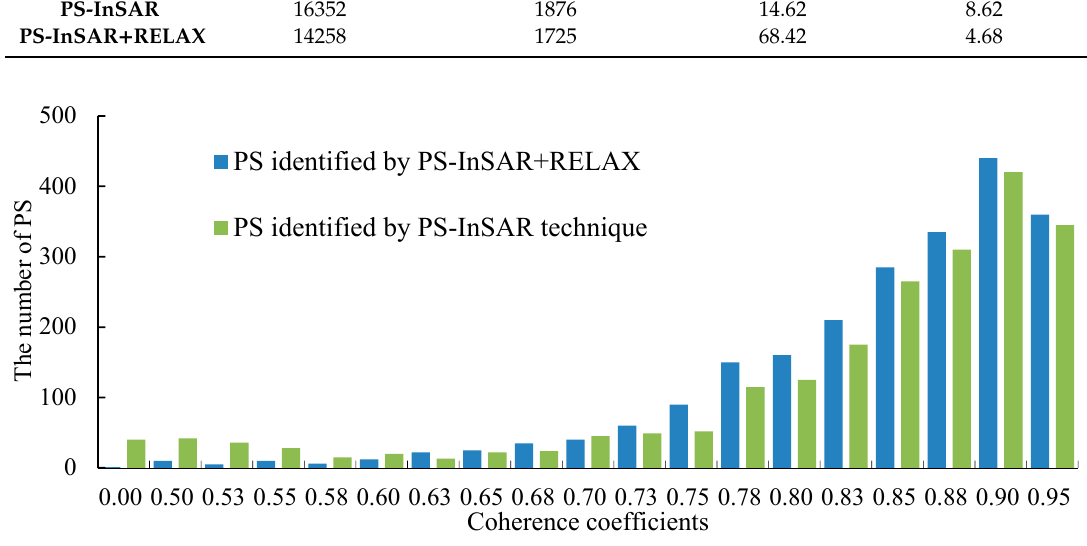
ffi cients for PS-InSAR and PS-InSAR + Figure 11. PS coherence coefficients for PS-InSAR and PS-InSAR+RELAX. Figure 11. PS coherence coe